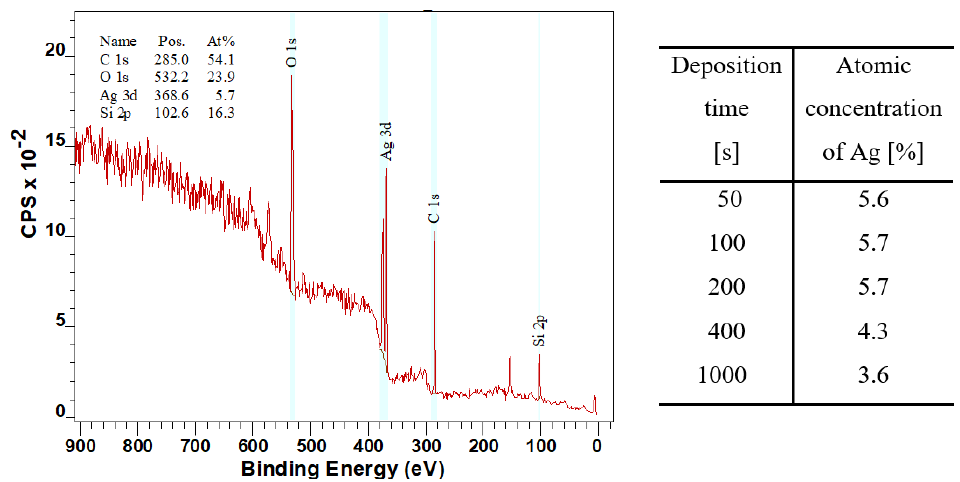
Figure 4. XPS spectrum for a sample deposited at 20 mA for 200 s and a table with the atomic concentration of Ag in prepared samples at a current of 20 mA with different sputtering times (50, 100, 200, 400, and 1000 s).